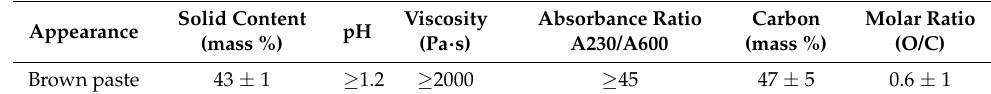
Table 2. Properties of graphite oxide.